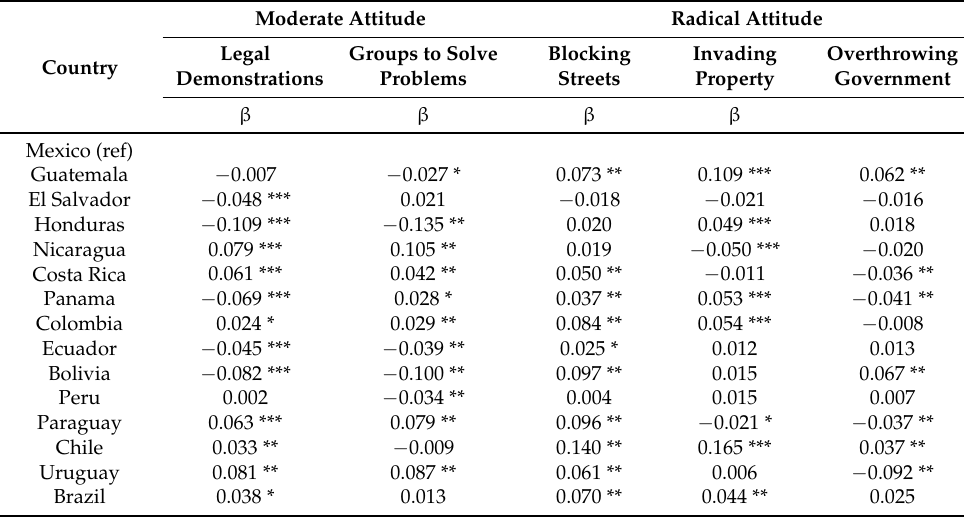
Table A2. Fixed effects for country of respondent—Linear Regression Models for Protest Attitudes.